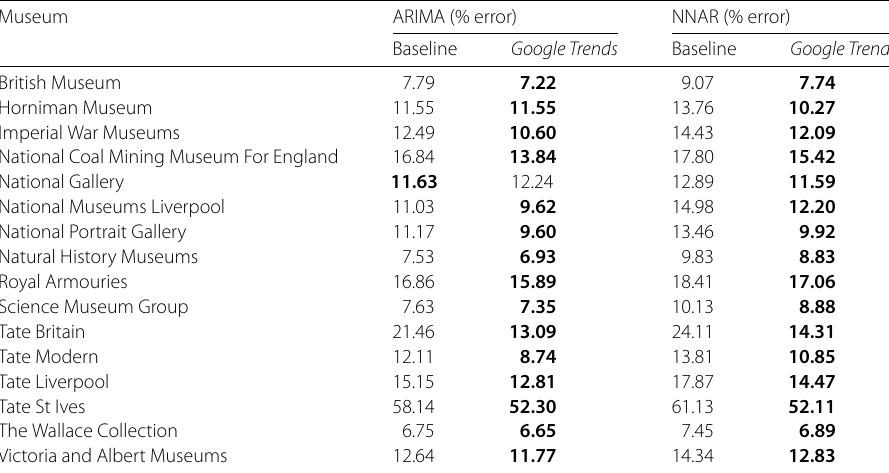
Table 1 Estimating museum visitor numbers using Google search data. We aim to generate rapid estimates of the monthly number of visitors at a given museum using adaptive nowcasting [19] with minimum delay as soon as each month is over. We build adaptive nowcasting models using autoregressive integrated moving average (ARIMA) models, and neural network autoregression (NNAR) models. For both families of time series models, we construct a baseline model using historical visitor numbers only. We also construct a Google Trends model, in which data on the volume of Google searches for a museum is used as an additional predictor. All models reported here are trained using the previous 60 months of data. We generate monthly estimates for the period between January 2010 and December 2018, and report the mean absolute percentage error (MAPE). For each comparison between a baseline model and an equivalent Google Trends model, the smallest MAPE is highlighted in bold. We observe that nearly all models which include data derived from Google Trends exhibit a smaller MAPE than their counterpart baseline model based on historical